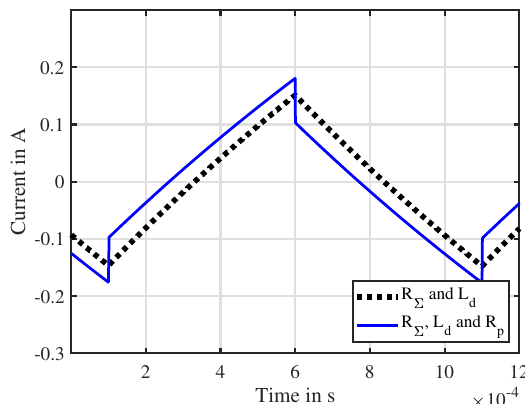
Figure 6. Simulated response of the current i s ( t ) in the electrical equivalent circuit when a pulse width modulated (PWM) voltage is applied in comparison to a classical RL circuit for the parameters U DC = 12 V, R Σ = 10 Ω , R p = 300 Ω and L d = 20 mH